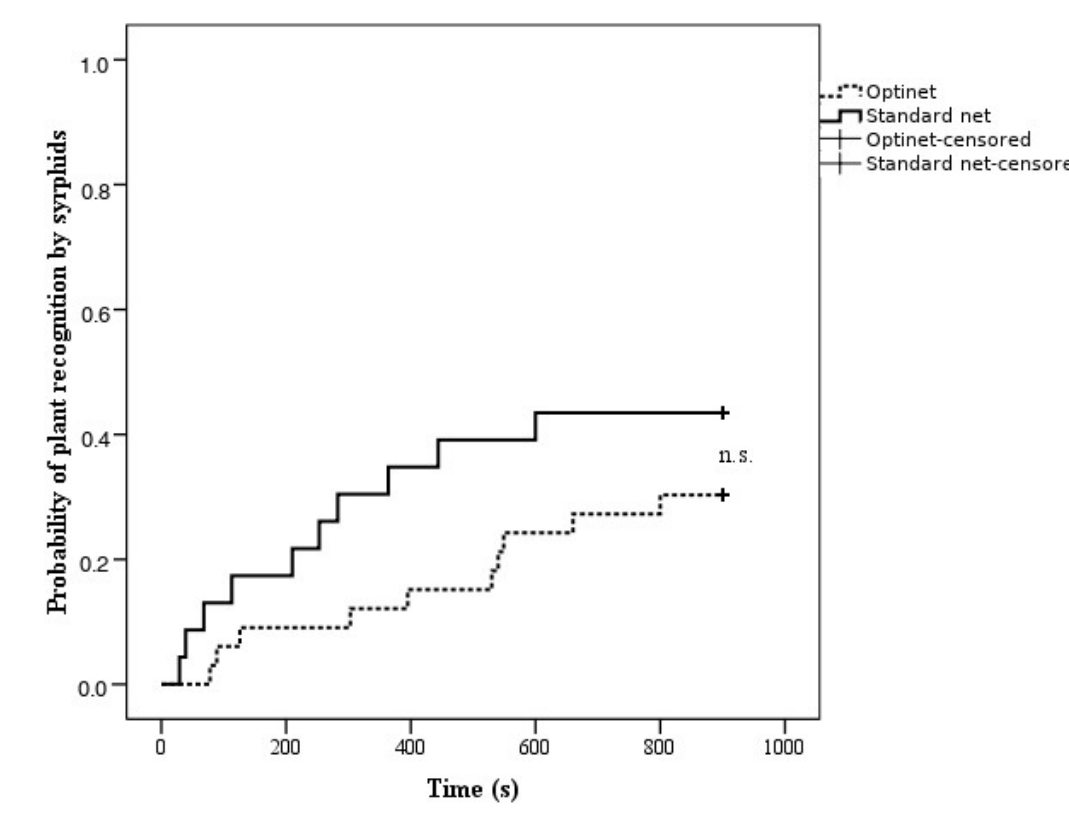
Figure 3. Cumulative proportion of syrphid females recognizing the flowering plant (sweet alyssum) (Kaplan–Meier) under Optinet (n = 33, dotted line) and Standard net (n = 23, drawn line).